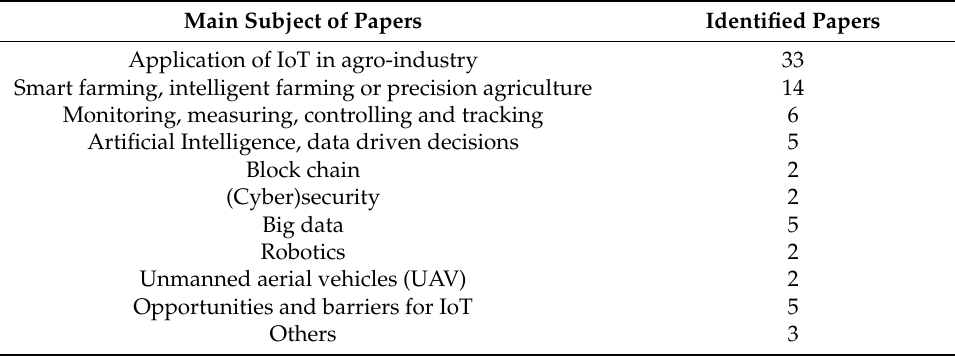
Table 3. Main results of IoT applied in agro-industry. Main Subject of